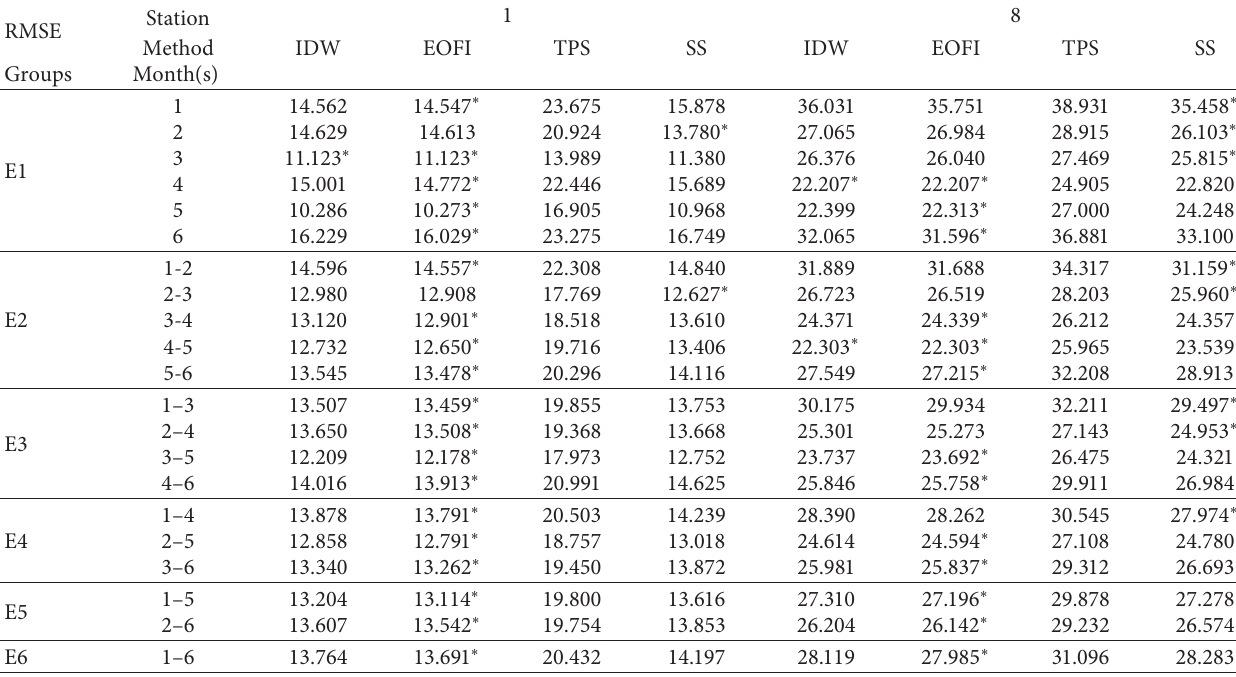
Figure 8: EOFI reconstruction sequence’s spatial modes, corresponding variance contributions, and the RMSE with optimal mode number of sta 1 (a1, c1, and b1) and sta 8 (a2, c2, and b2) in the first half of the year. The legend color red, green, blue, magenta, yellow, and black represent the experimental groups with durations of 1, 2, 3, 4, 5, and 6 months, respectively. Table 4: RMSE of four interpolation methods in sta 1 and sta